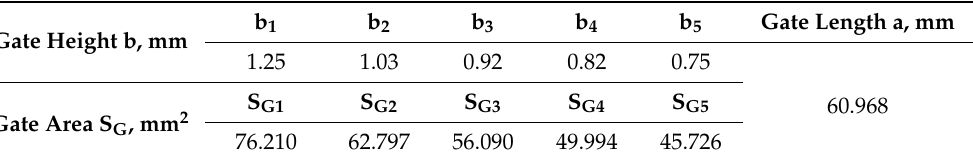
Table 2. Gate dimensions.